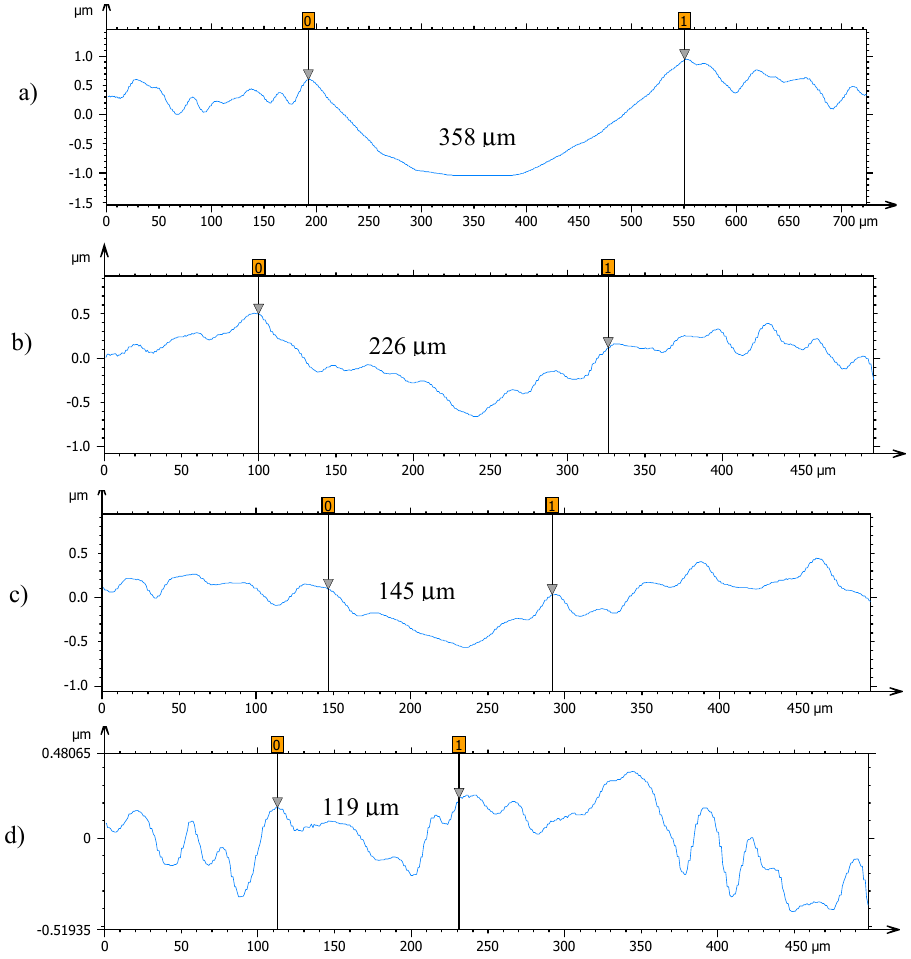
Figure 11. Cross section profiles of the wear tracks on the pins lubricated with ( a ) TMPTO, ( b ) TMPTO + 0.015 wt% Fe 3 O 4 (6.3 nm), ( c ) TMPTO + 0.015 wt% Fe 3 O 4 (10 nm) and ( d ) TMPTO + 0.015 wt% Nd alloy (19 nm). Table 5. Roughness parameters, Ra , and their uncertainties σ of worn surfaces lubricated with the three studied nanodispersions and neat TMPTO.